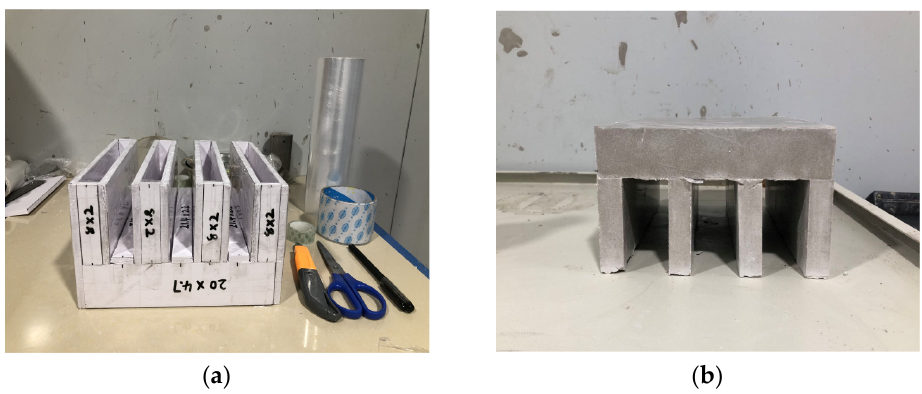
Figure 3. ( a ) Molds for making concrete models and ( b ) Gridded hard crust